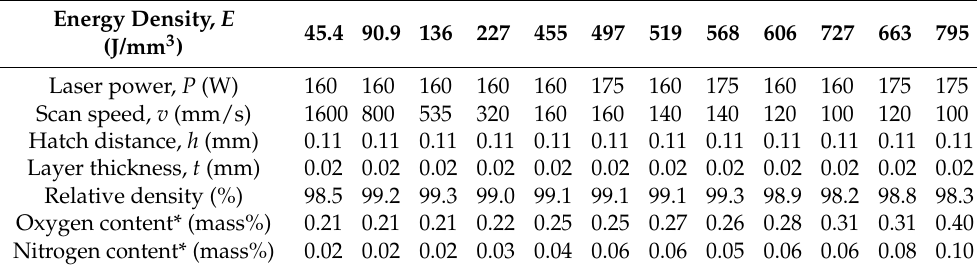
Table 2. Selective laser melting (SLM) parameters for fabricating the Ti64 alloys and summary of the measured relative density, oxygen content, and nitrogen content of the SLM Ti64